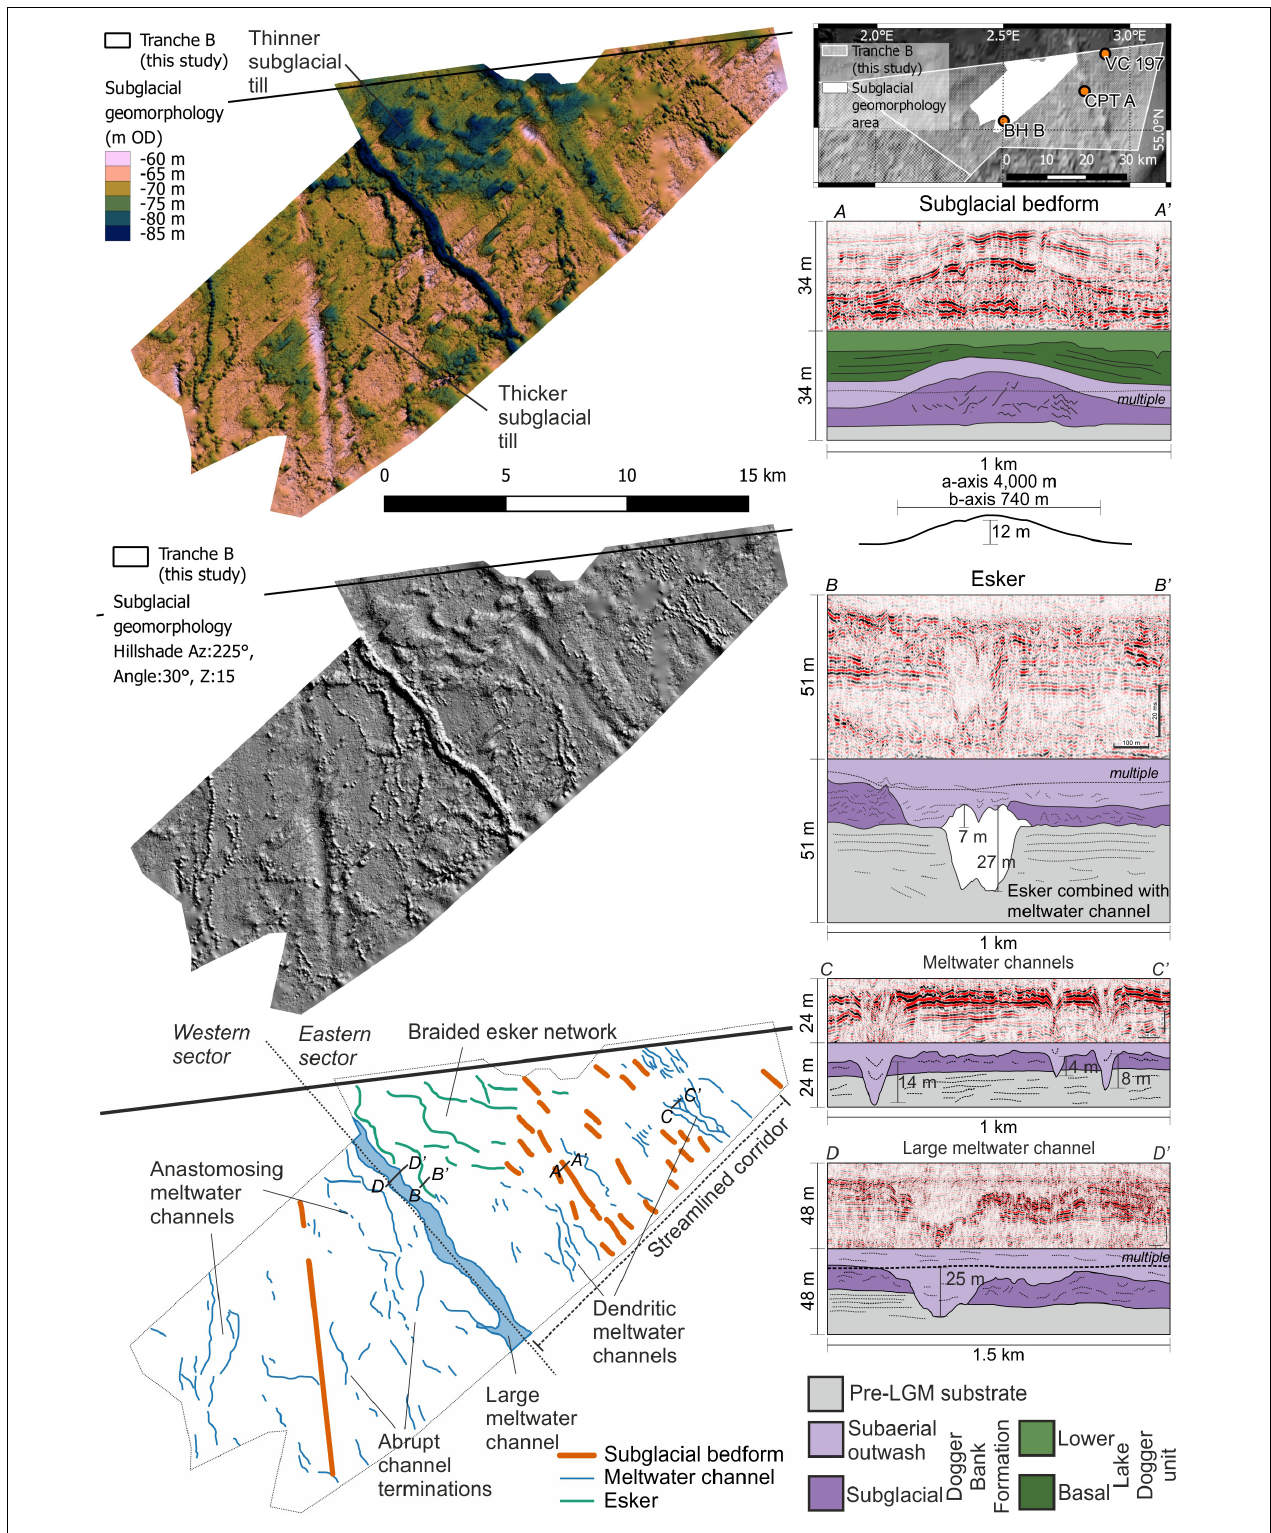
FIGURE 6 | Elevation-colored and hillshaded maps of the Lower sub-unit of the Dogger Bank Formation with a detailed interpretation showing subglacial bedforms, meltwater channels and eskers. Cross-sectional morphology of a subglacial bedform (A,A’) , an esker (B,B’) , the smaller meltwater channels (C,C’) , and the large meltwater channel (D,D’) are shown in the seismic sections. Color bar “Batlow” from Crameri (2018).